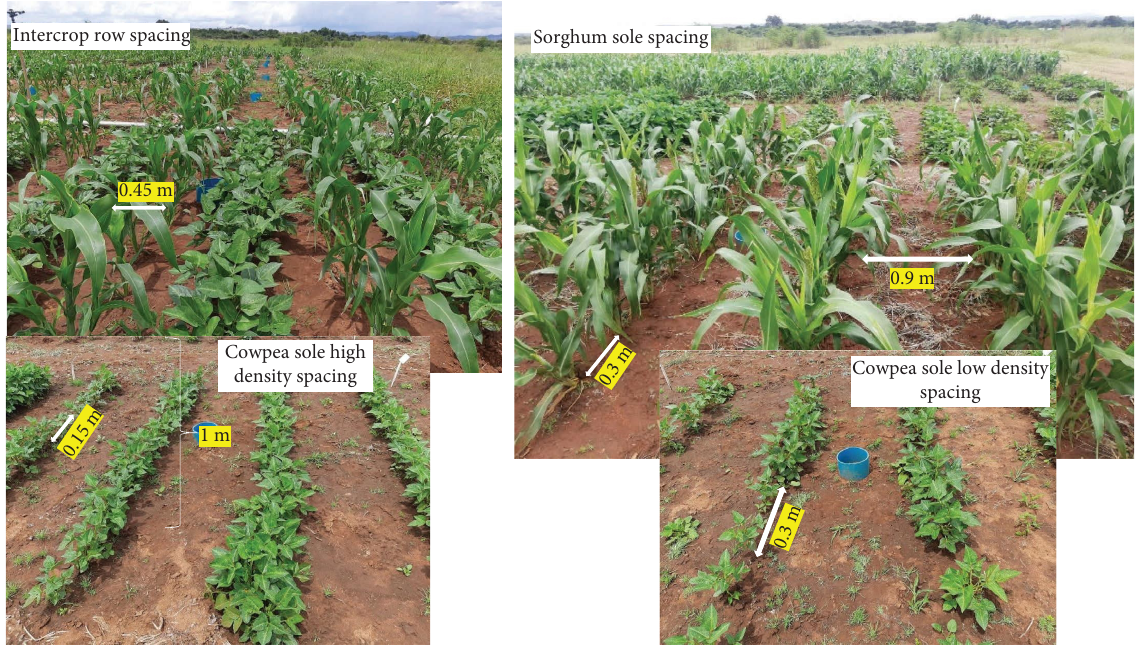
Figure 4: Binary and sole row arrangements.